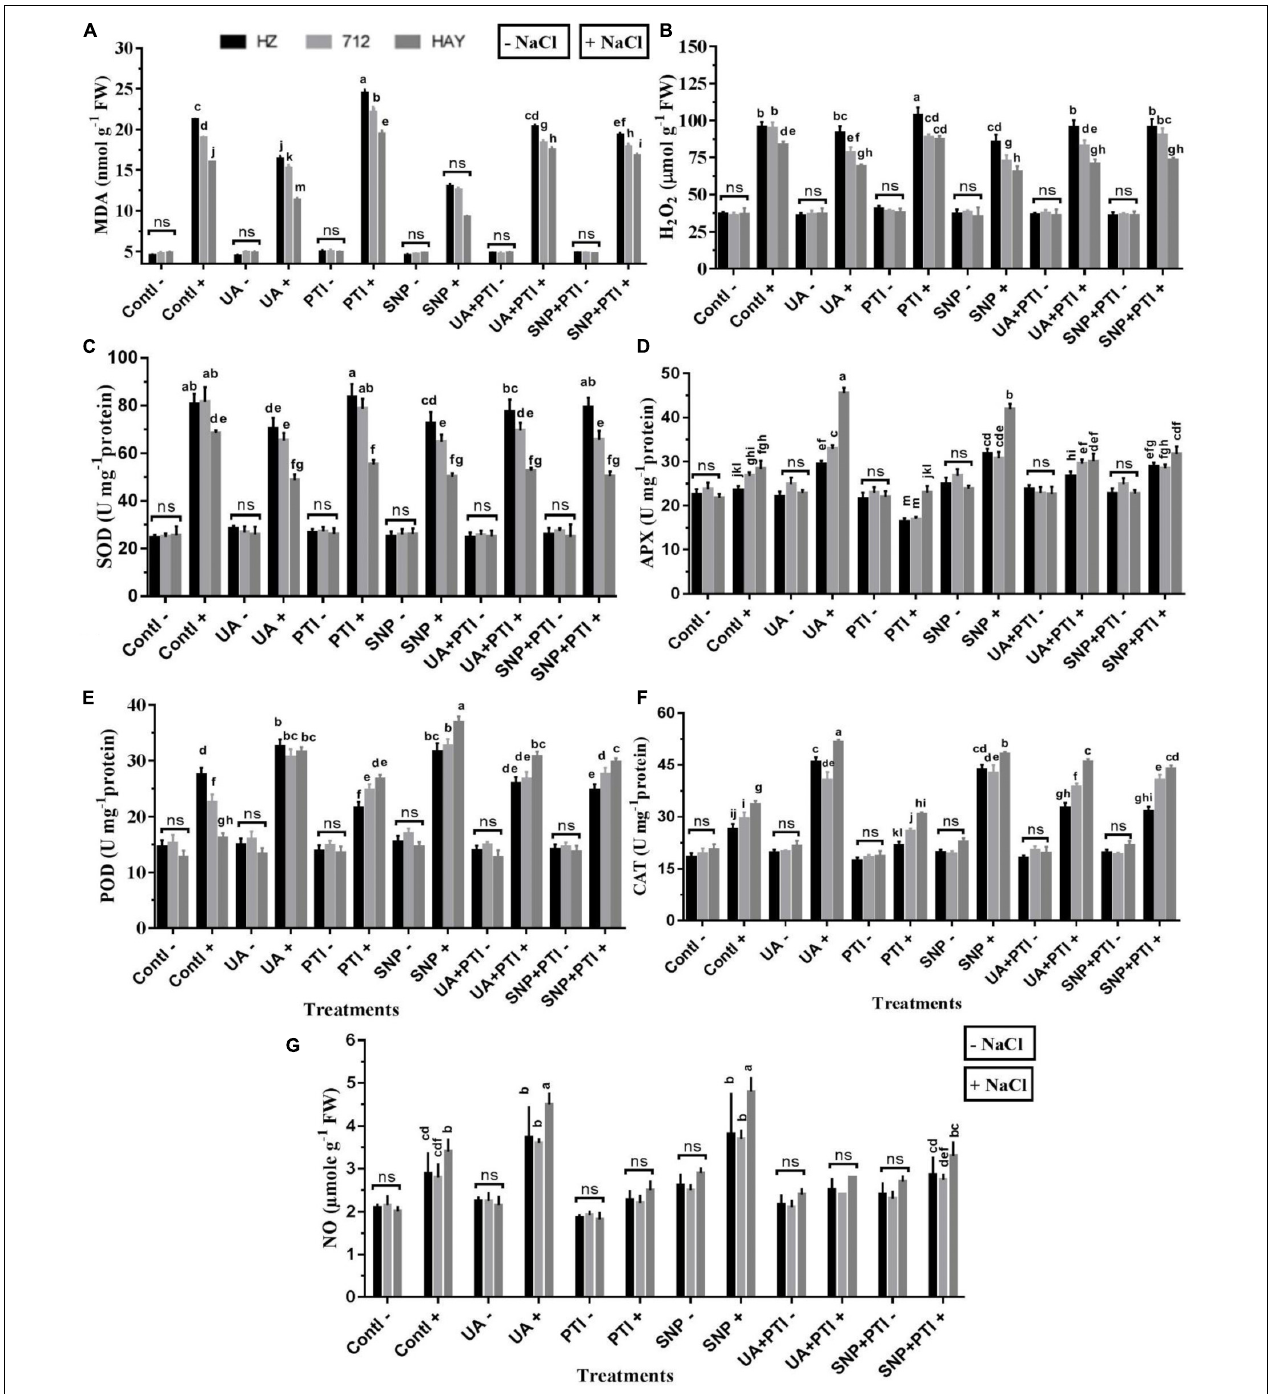
FIGURE 6 | Pharmacological experiment supported the requirement of NO production in Ursolic acid (UA) alleviated NaCl salinity. Redox balance (A,B) and antioxidant enzymes activities (C–F) were reestablished by UA mediated NO production (G) under salinity stress treatment (8 dS m − 1 ). Fourteen-day-old rice plants were pretreated with 100 µ M UA, 10 µ M SNP, 100 µ M PTI, alone or their combinations for a day, and then transferred to 8 dS m − 1 for another seven days. Means with the same letters are not significantly different based on three-way ANOVA followed by Dunca’s test ( P ≤ 0.05) for each cultivar at different salt stress treatments. The results are shown the mean ± SE of five replicates and three/four plants were bulked for each replicate. Contl = control, UA = ursolic acid, PTI = 2-(4-carboxyphenyl)-4,4,5,5-159 tetramethylimidazoline1-oxyl-3-oxide potassium salt, SNP = sodium nitroprusside. “ − ” NaCl absent, “ + ” NaCl present, ns: not statistically significant ( p > 0.05). Three-way interaction of factors is presented in Supplementary Table 2 .